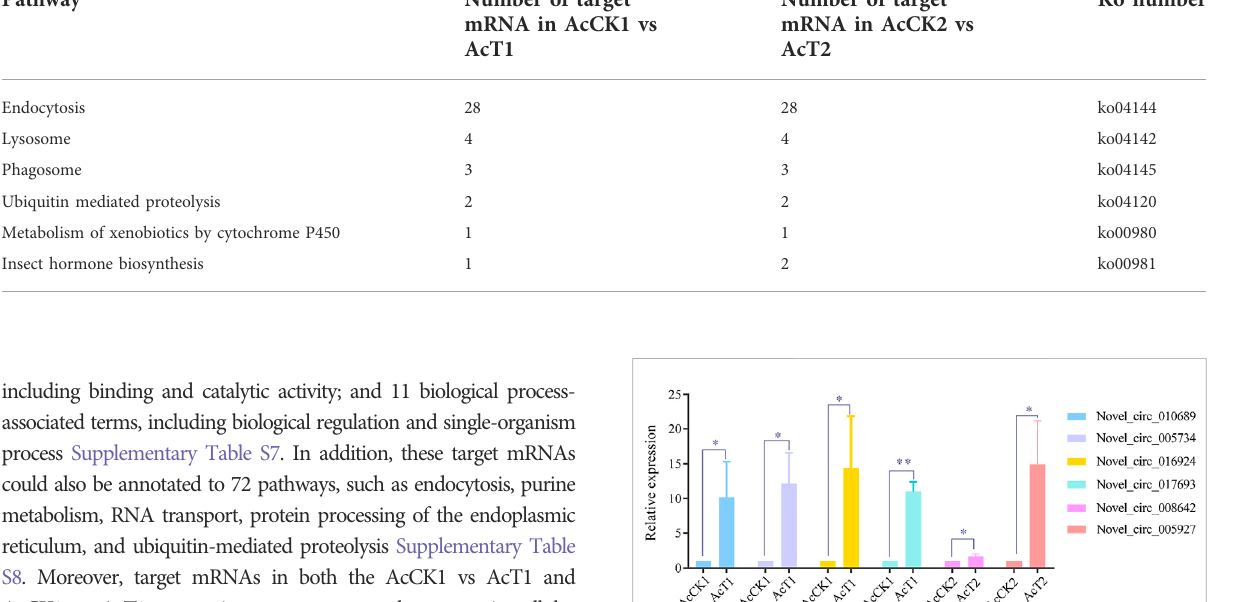
FIGURE 6 RT-qPCR veri fi cation of DEcircRNAs.Student ’ s t test, “ * ” indicates p ≤ 0.05 and “ ** ” indicates p ≤